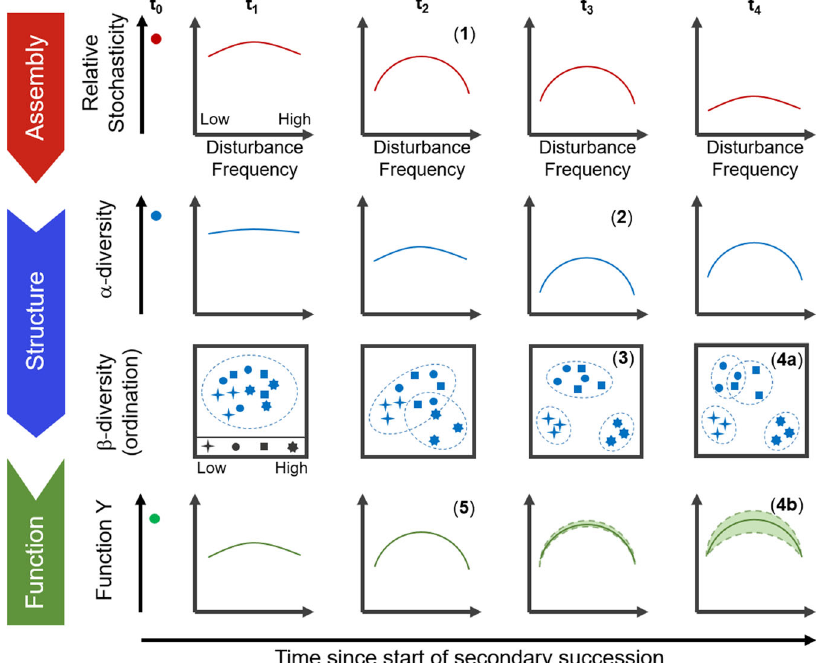
Fig. 4 Conceptual representation of the intermediate stochasticity hypothesis (ISH) to describe patterns of assembly and structure along a disturbance frequency gradient, for communities in secondary succession (starting at time point t 0 ). ( 1 ) Initially, stochastic assembly mechanisms (e.g., priority effects, historical contingency and legacy effects) are favored at intermediate disturbance frequencies, promoting re-colonization processes from the low-abundance fraction of the community or seed bank. ( 2 ) Subsequently, these are followed by changes in the community structure that manifest as a peak of α -diversity at intermediate levels of disturbance. ( 3 ) Over time, three separated clusters of β -diversity ordination may form comprising low, intermediate, and high levels of the disturbance range (in this schematic, n = 3). Furthermore, stochasticity operating at intermediate disturbance levels may lead to variable within-treatment ( 4a ) β -diversity, visualized as partially overlapping cluster similarity (dashed ovals), and ( 4b ) community function, displayed as wider con fi dence intervals (shaded area between dashed lines). ( 5 ) The output of some functions (in this study, nitrogen removal) could be higher at intermediate disturbance frequencies during initial successional stages due to higher stochastic assembly. Additionally, the overall relative contribution of stochasticity decreases with succession time (see top row of